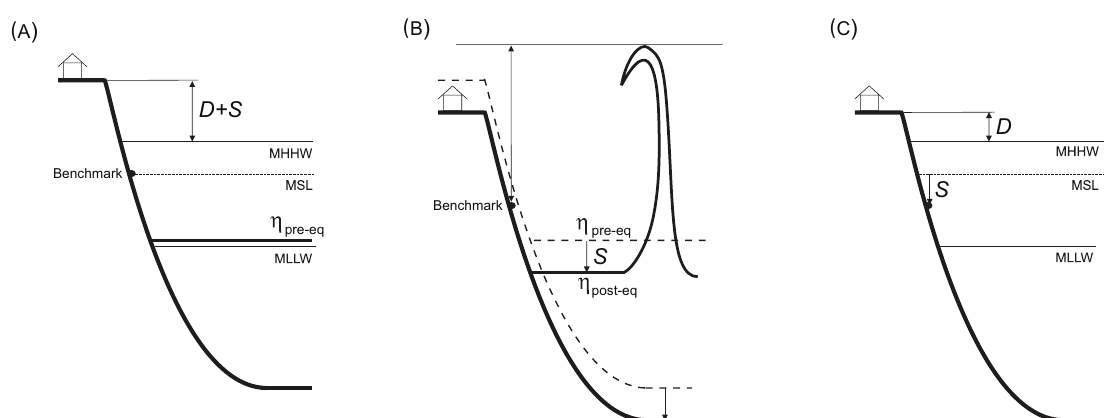
Fig. 7. A schematic drawing of the city harbor before the earthquake (A) , after the earthquake during the landslide-generated tsunami (B) , and the present day (C) .